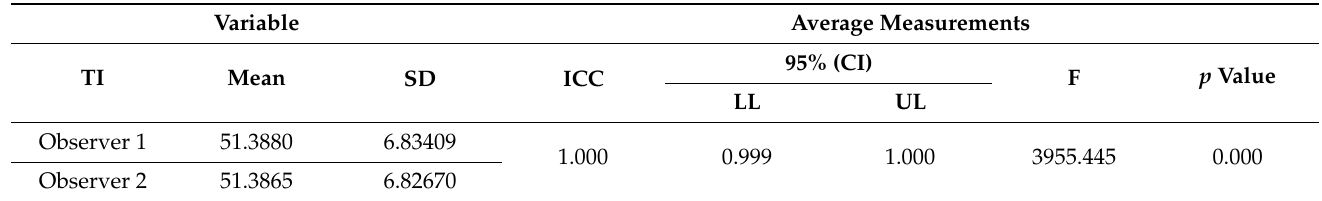
Table 9. Values in the ICC in the interobserver assessment of Total Index (TI) and average